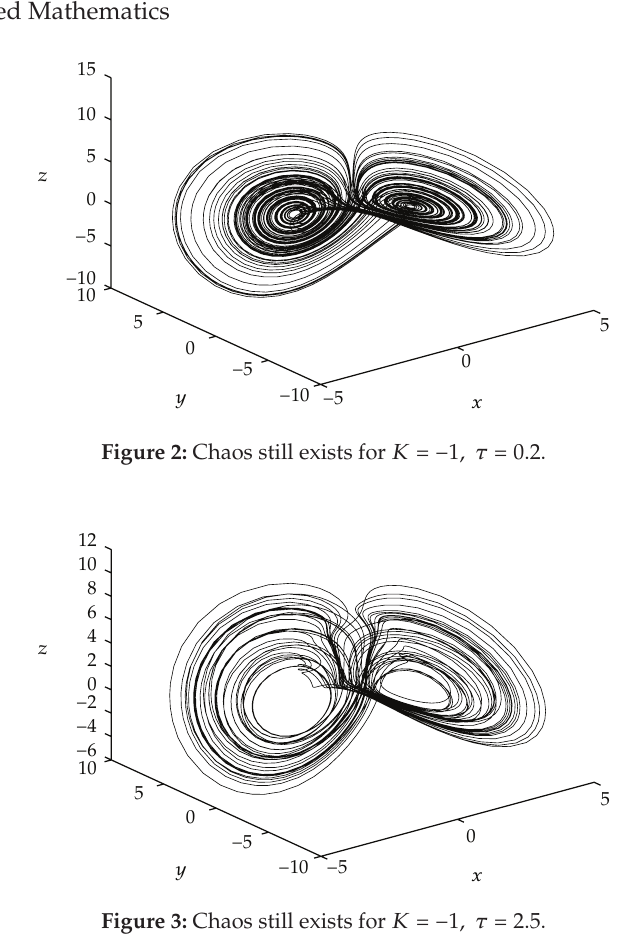
Figure 3: Chaos still exists for K (cid:7) − 1 , τ (cid:7) 2 .